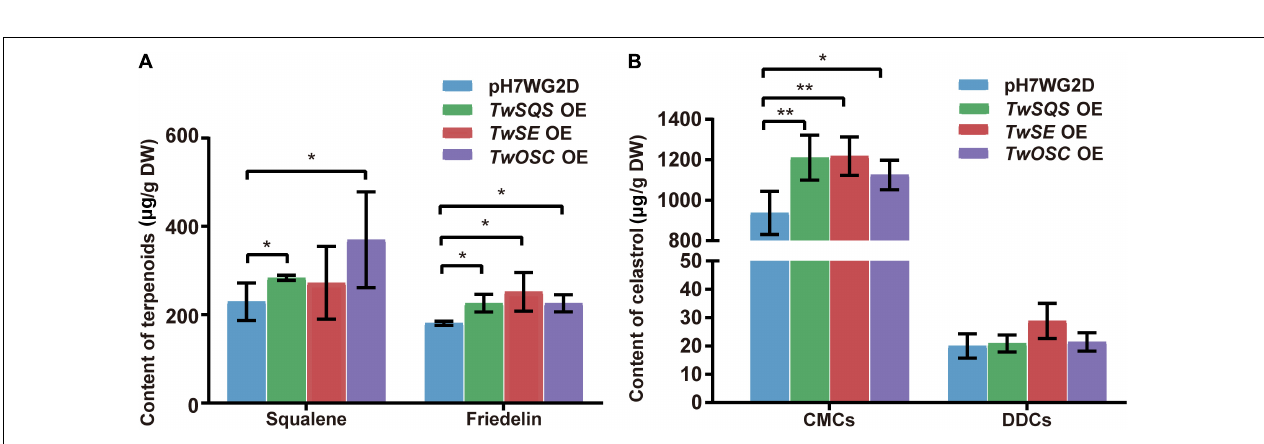
FIGURE 3 | Accumulation of squalene, friedelin, and celastrol in Tripterygium wilfordii CMCs and DDCs after overexpressing TwSQS , TwSE , and TwOSC. (A) Accumulation of squalene and friedelin in CMCs. (B) Accumulation of celastrol in CMCs and DDCs. OE, overexpression; DW, dry weight. The data are summarized as means ± standard deviation. * p < 0.05 and ** p < 0.01, n = 5. Student’s t -test.